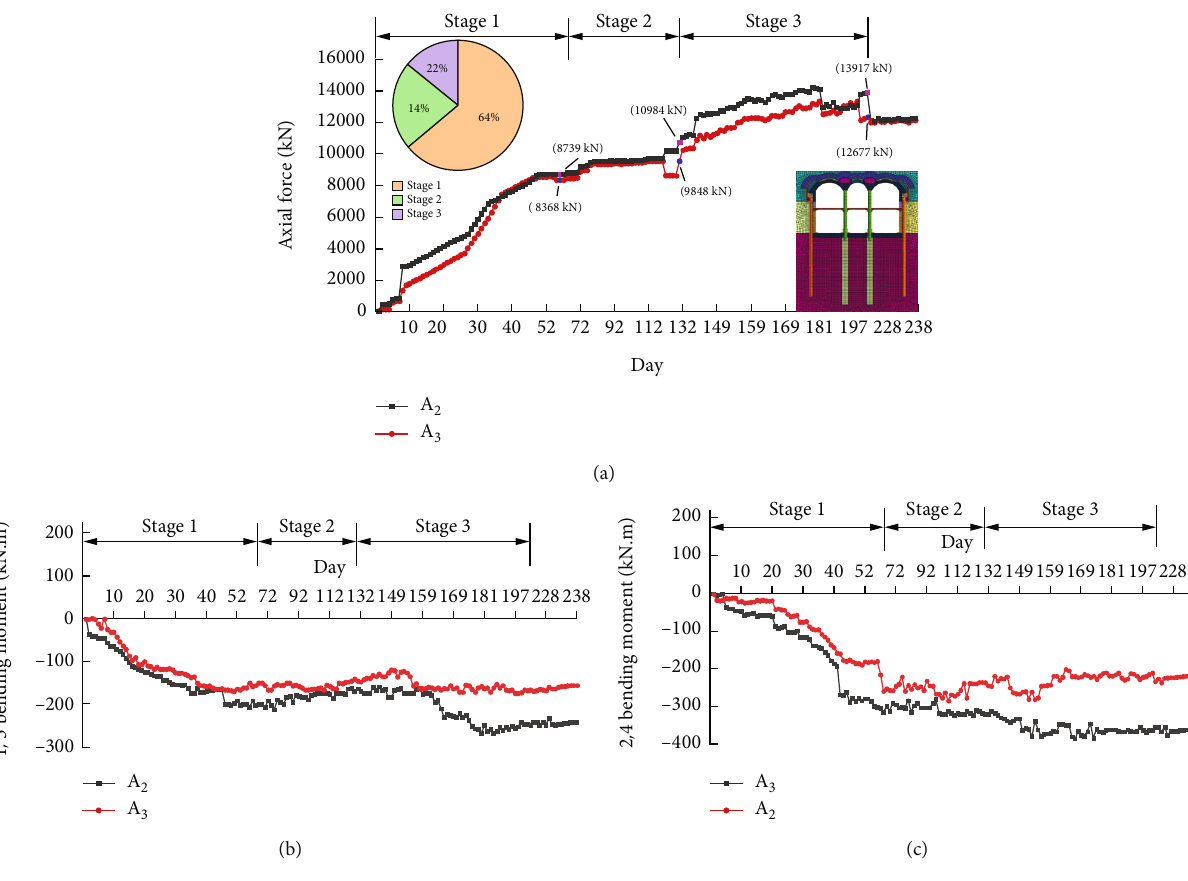
Figure 15: Internal change of the steel pipe column in the construction process of the Jinrongjie Station. (a) Axial force change during the construction. (b) Bending moment change in 1,3 directions during the construction. (c) Bending moment change in 2,4 directions during the